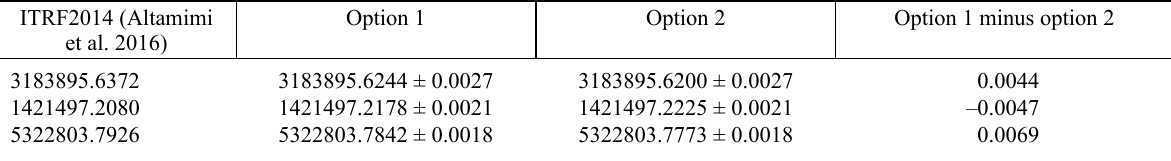
 ,, (m) in the ITRF2014 ZYX